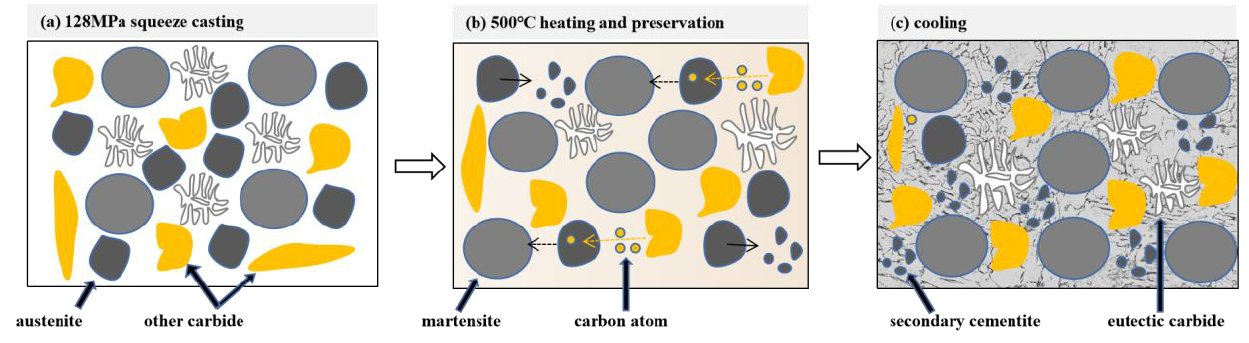
Figure 11. Microstructure evolution diagram of 500 °C subcritical quenching process: ( a ) microstruc- ture of 128 Mpa squeeze casting HCCI without heat treatment, ( b ) phase transformation diagram of extruded HCCI during 500 °C heating and preservation, ( c ) final phase diagram after heat treatment and cooling.